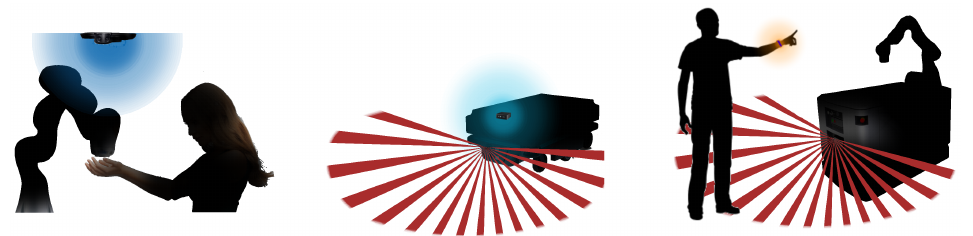
Figure 2. Relevant sensors for HRP within the industrial context. Vision sensors are highlighted in blue, safety laser scanners rays in red, and wearable sensors in orange.